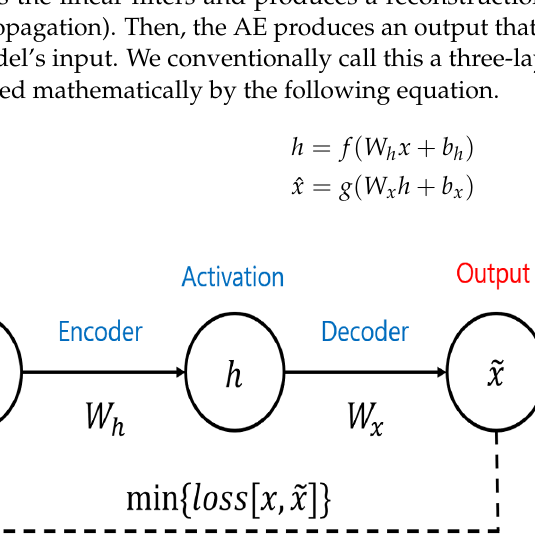
Figure 4. Basic architecture of the